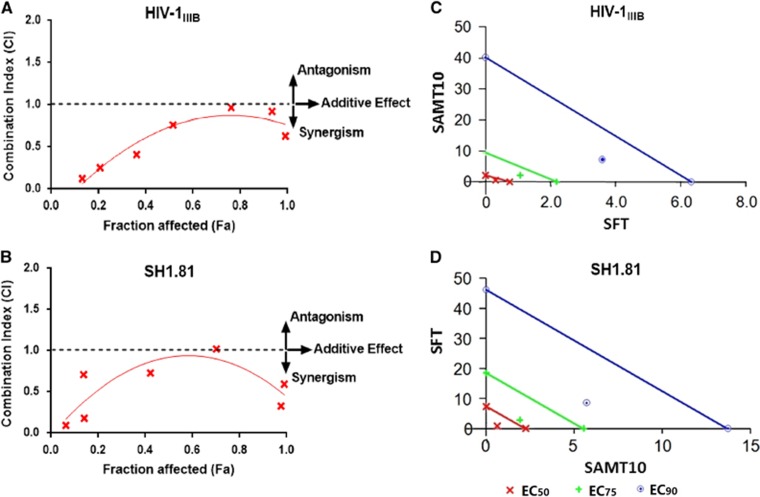
Combinatorial use of SAMT10 and SFT produces a synergistic effect for most doses evaluated. (A, B) The Chou–Talalay CI of the SAMT10 and SFT combination against the HIV-1 laboratory-adapted strain IIIB (subtype B, X4) and HIV-1 pseudovirus SH1.81 (01_AE, R5) was calculated. CI<1 indicates synergism. (C, D) Isobologram analysis of SAMT10 and SFT combination against the laboratory-adapted strain IIIB (subtype B, X4) and the pseudotyped virus SH1.81 (01_AE, R5), respectively. combination index, CI; 50% effective concentrations, EC50; 75% effective concentrations, EC75; 90% effective concentrations, EC90; S-acyl-2-mercaptobenzamide thioester-10, SAMT10; sifuvirtide, SFT. The results are representative of three independent experiments, where each experiment was performed in triplicate.